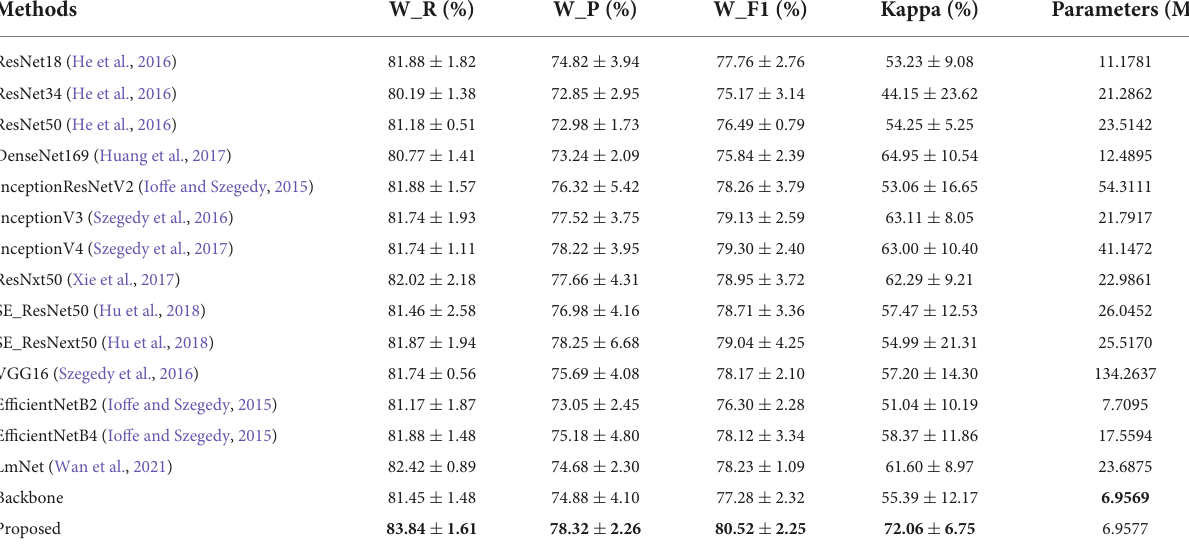
TABLE 3 The results of comparable experiments on specific classification of corneal